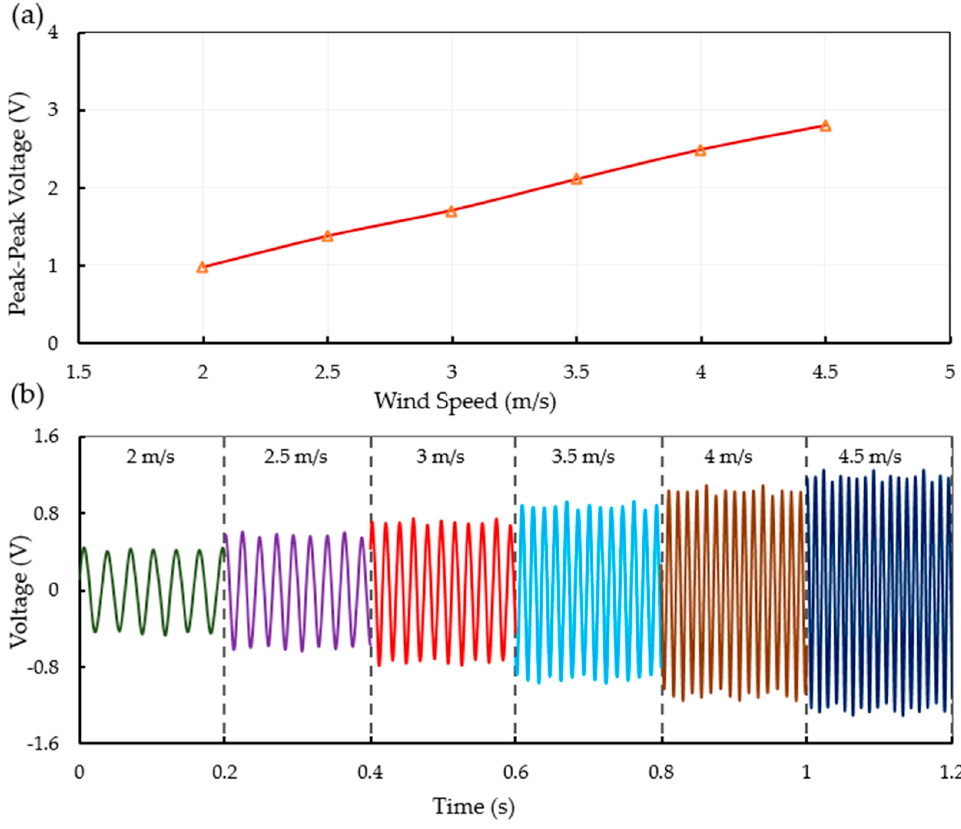
Figure 5. ( a ) Peak to peak open-circuit voltages and ( b ) generated voltage waveforms for various wind speeds.